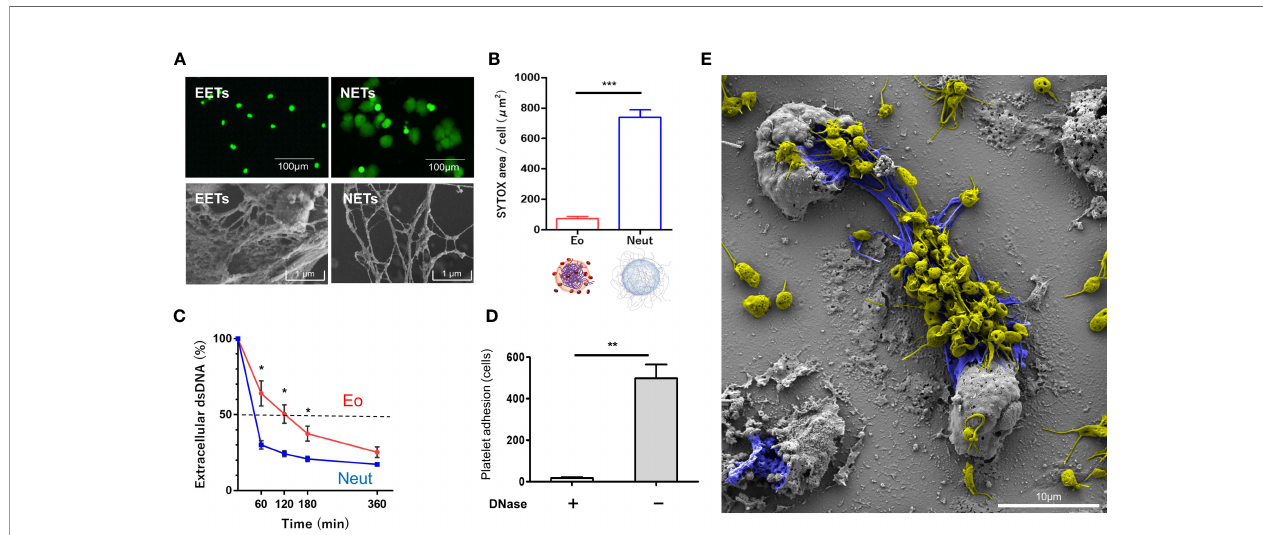
( Figure 5E ). Filopod formation and aggregation of platelets indicated their active